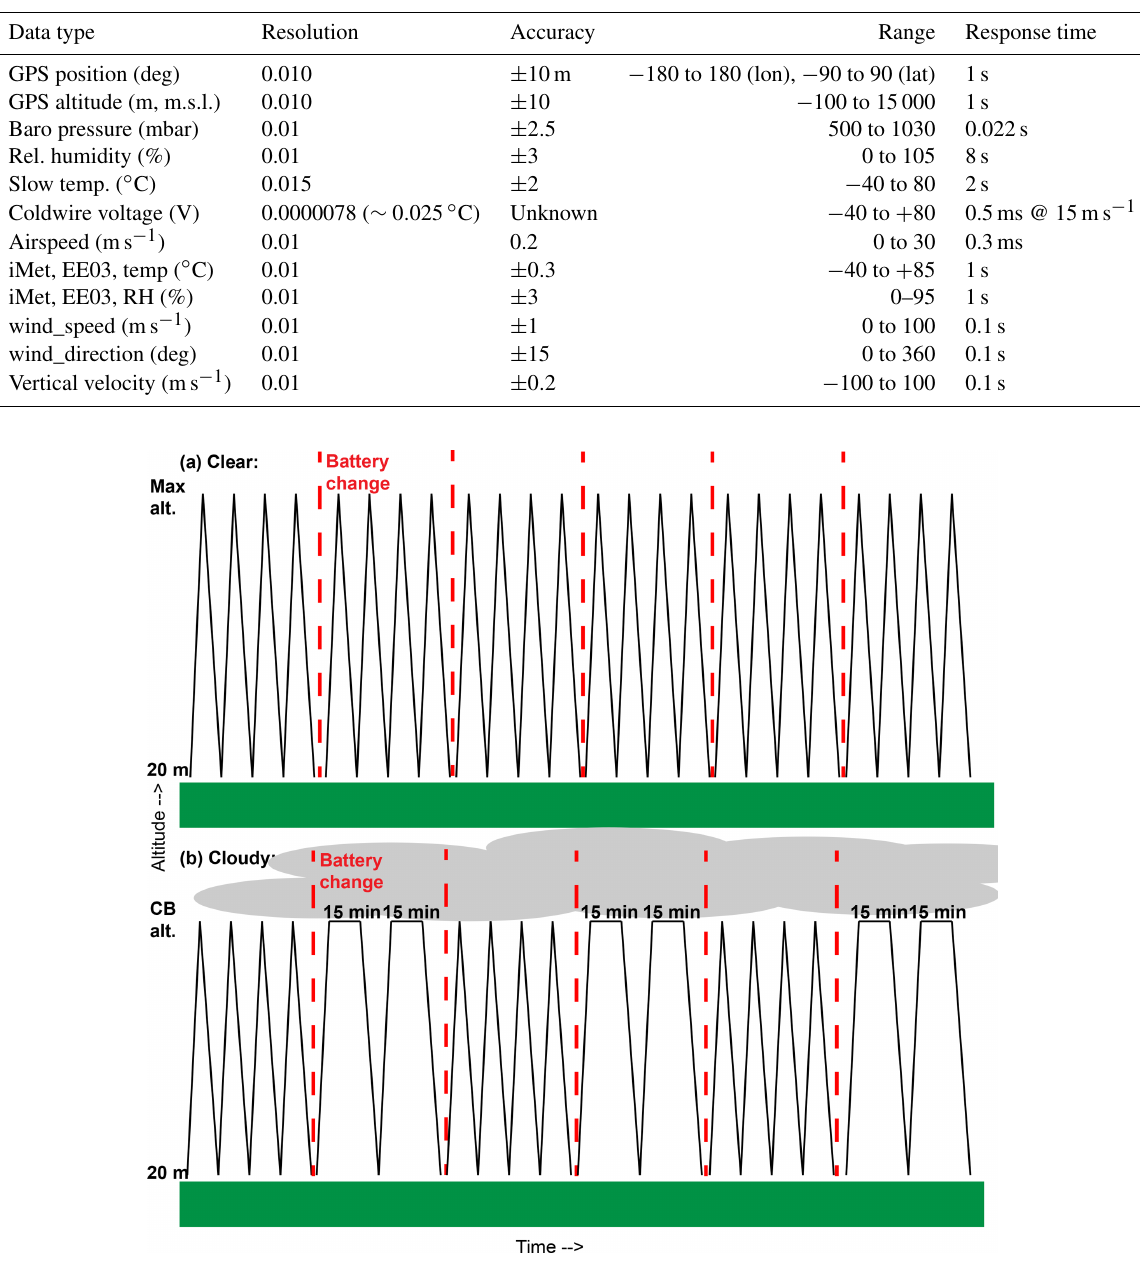
Figure 3. An illustration of the proposed DataHawk2 flight pattern for clear (a) and cloudy (b) conditions. The black lines are the proposed flight pattern on a time axis, while the red lines indicate battery changes in between